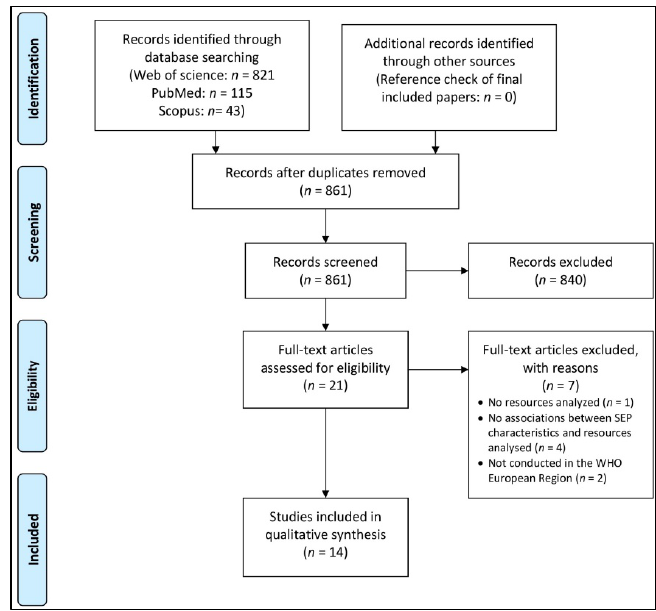
Figure 1. Flow diagram of study selection adapted from the PRISMA statements [28].